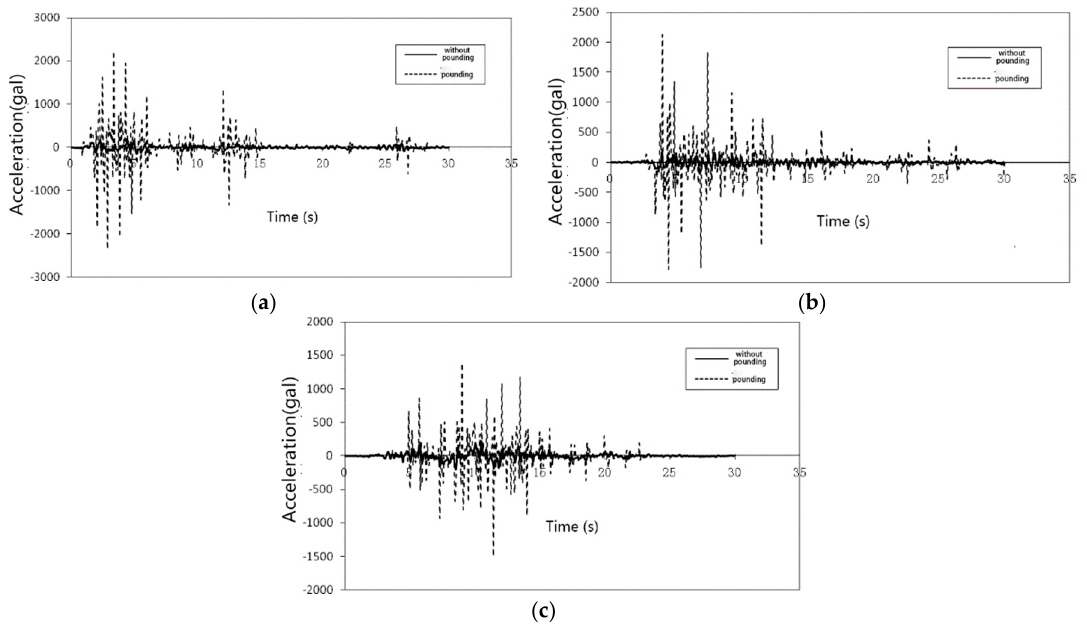
Figure 16. Structural acceleration under different earthquakes (model A). ( a ) El Centro earthquake; ( b ) Taft earthquake; and, ( c ) Artificial excitation.